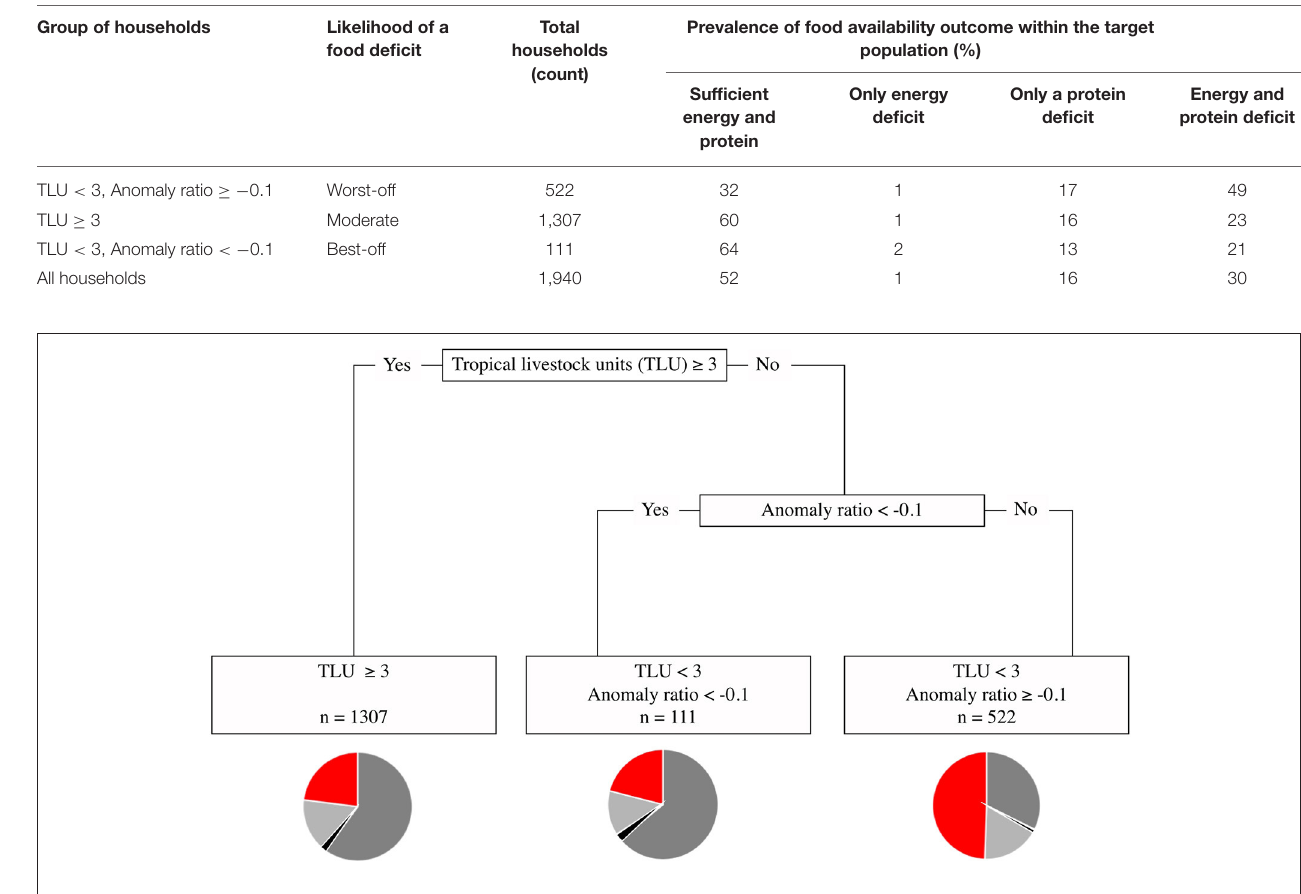
FIGURE 4 | Logistic model tree for households in Mozambique. The tree produces four groups of households, represented as terminal nodes. Household consumption equivalents (CE), the anomaly ratio of the last reasons’ rainfall and the area of land under cultivation over the last major growing season predict food availability status.